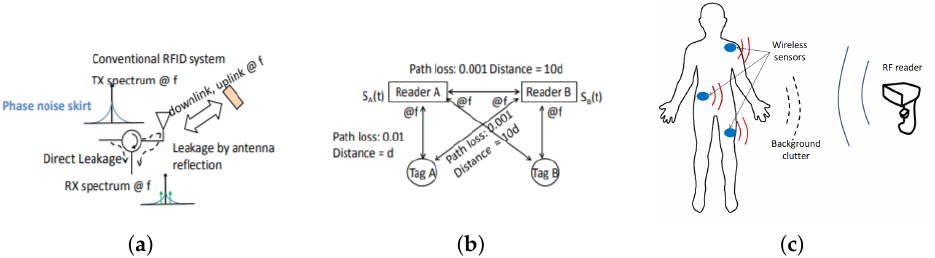
Figure 1. Different sources of clutter ( a ) self-jamming [25], ( b ) multi-reader jamming [25], [Repro- duced with permission from Y. Ma, A passive broadband harmonic Radio Frequency Identification (RFID) platform; published by IEEE, 2016.] ( c ) Reflection from human body in a body area network (BAN) sensor [27]. [Reproduced with permission from S. Mondal, Scope and application of harmonic RFID for implanted body area network; published by IEEE, 2020].